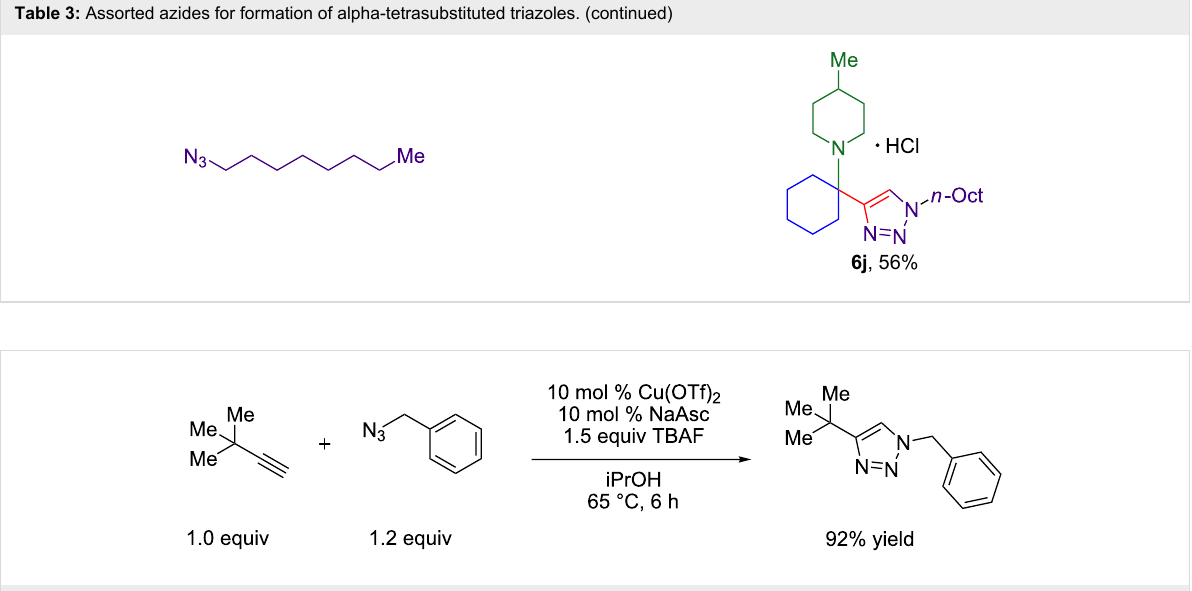
Table 3: Assorted azides for formation of alpha-tetrasubstituted triazoles. (continued)